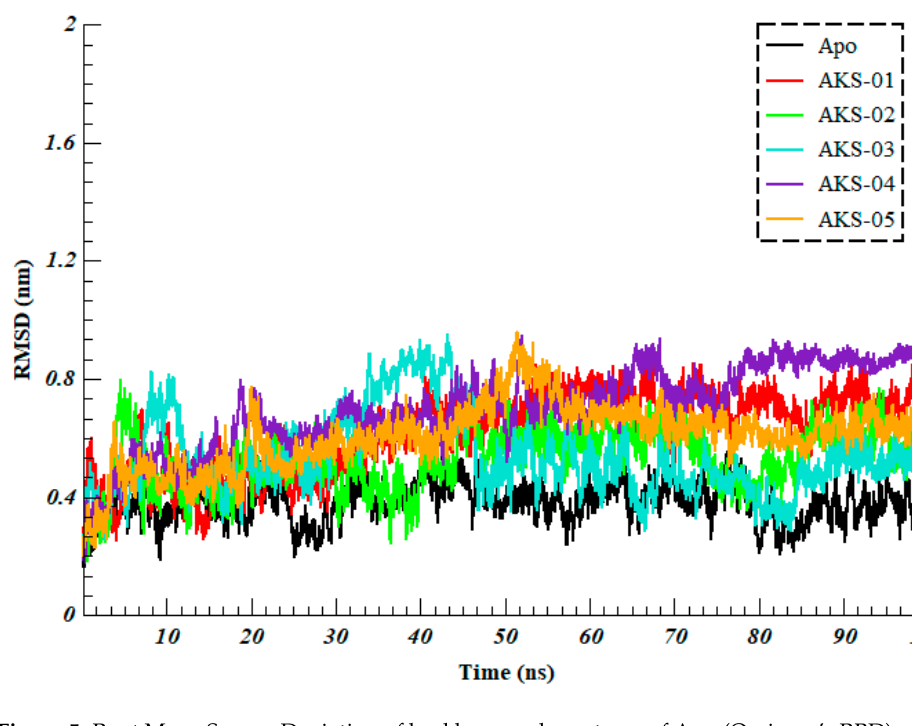
Figure 6. Root Mean Square Fluctuation of residues of Apo (Omicron’s RBD) and five selected com- pounds in complex with RBD over the 100 ns of simulation time.